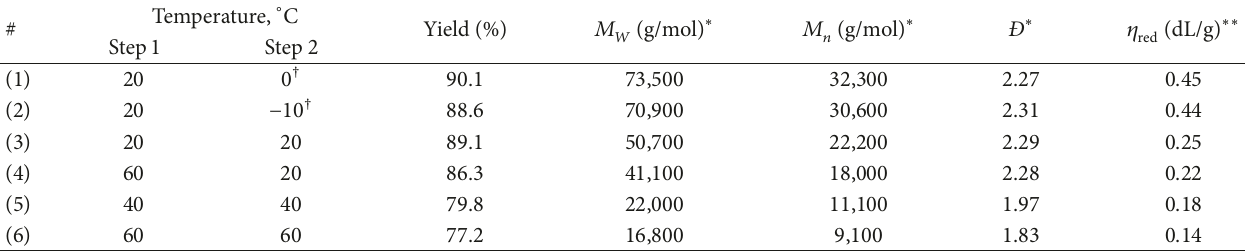
Table 9: The influence of reaction temperature on the characteristics of PE8E4.